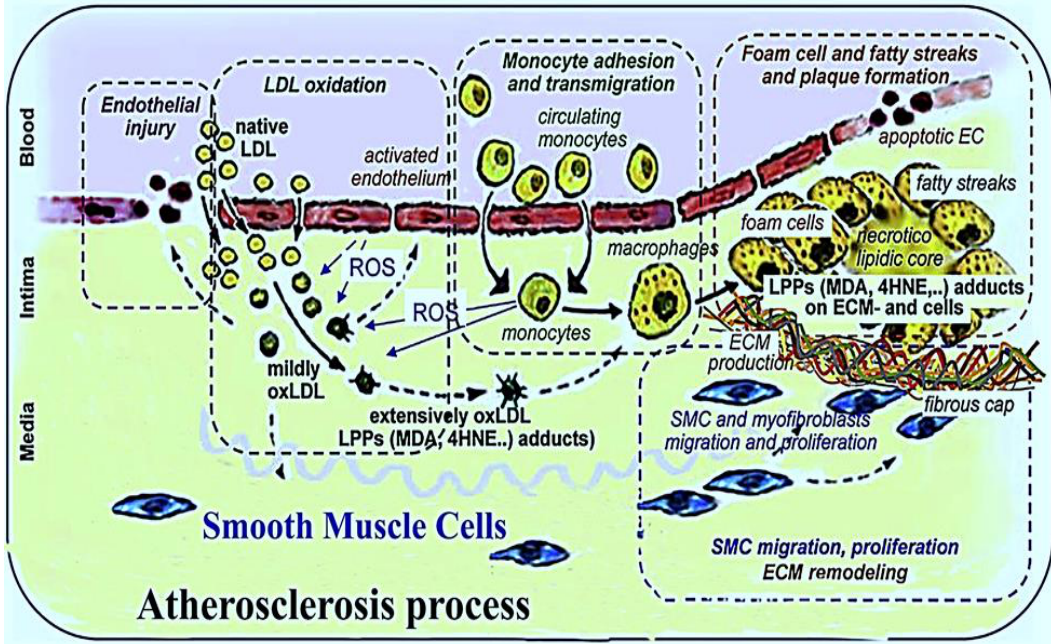
Figure 1. The main atherosclerotic events [39].